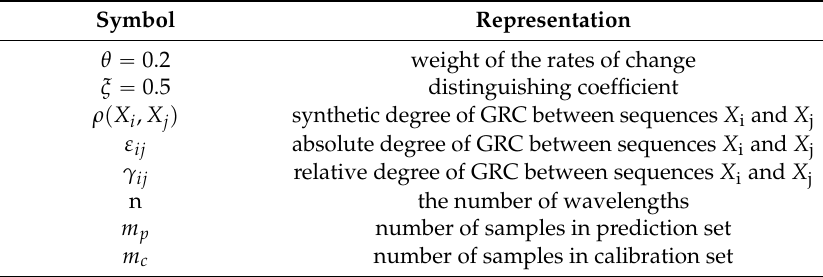
Table 1. The summary of symbols used in the calculation process of S-GRC. Symbol Representation θ “ 0.2 weight of the rates of change ξ “ 0.5 distinguishing coefficient ρ p X i , X j q synthetic degree of GRC between sequences X i and X j ε ij absolute degree of GRC between sequences X i and X j γ ij relative degree of GRC between sequences X i and X j n the number of wavelengths m p number of samples in prediction set m c number of samples in calibration